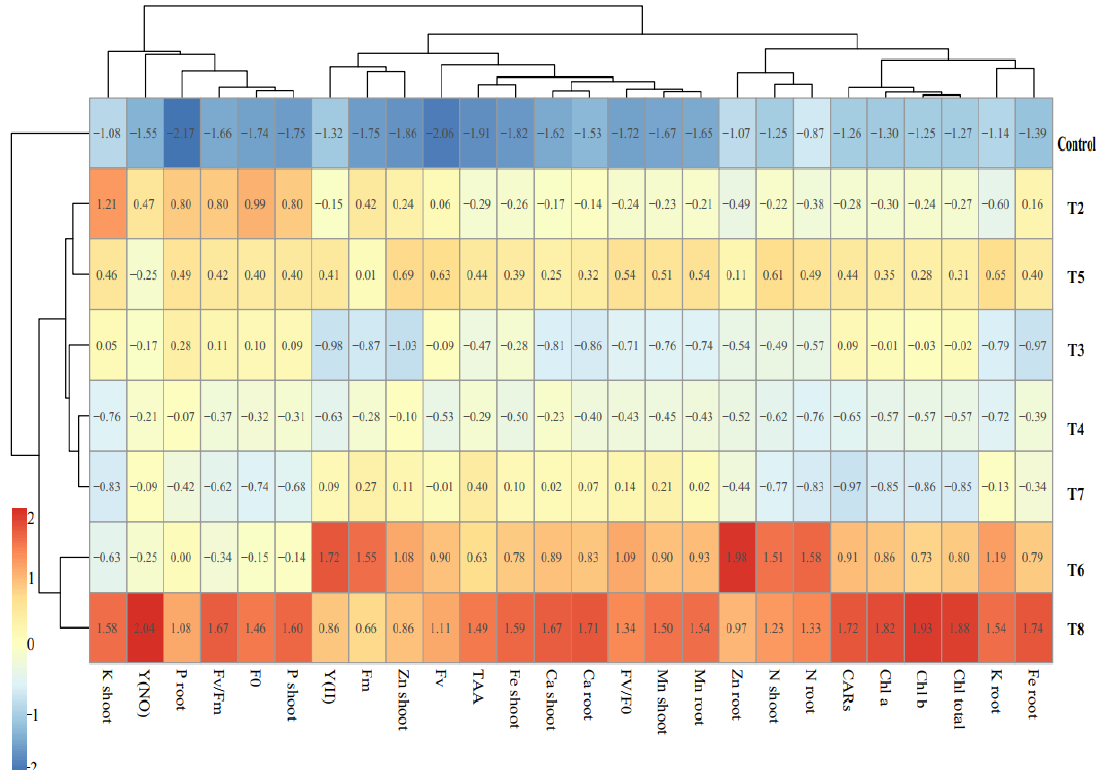
Figure 4. Cluster analysis heat map for the response of arbuscular mycorrhiza fungi (AMF) inocu- lation and seaweed extracts (SWE) foliar application to Lactuca sativa L. Photosynthesis pigments (chlorophyll a (Chl a ), chlorophyll b (Chl b ), total chlorophyll (Chl total), carotenoids (CARs), fluo- rescence chlorophyll parameters ( F 0 , F v , F m , F v / F m , F v / F 0 , Y(NO), Y(II),), mineral pool (N, P, K, Ca, Fe, Zn, Ca concentrations in shoots and roots), and total antioxidant activity (TAA), evaluated for the plants represented eight traits with different treatment combinations.